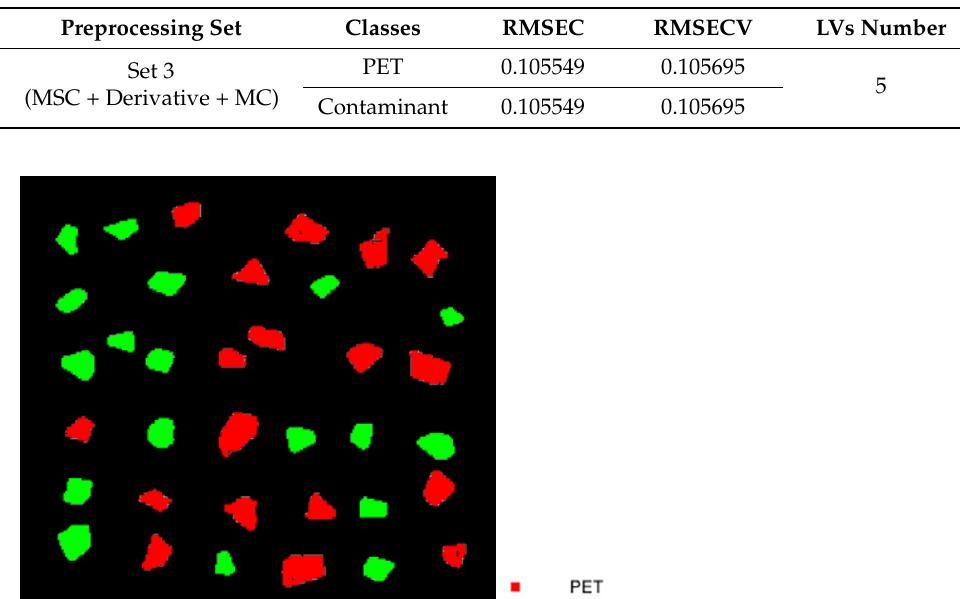
Table 5. Root mean square error for calibration (RMSEC) and cross-validation (RMSECV) for the full